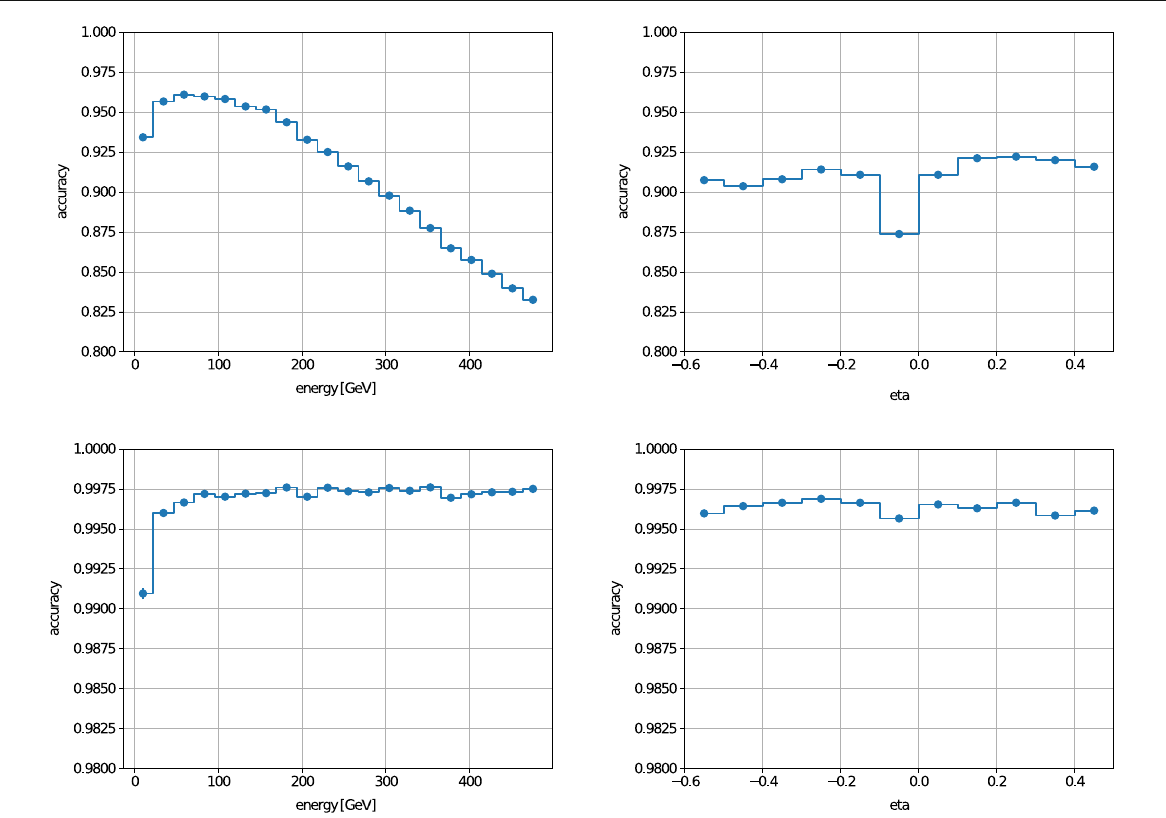
Fig. 14 Classification accuracy of best performing network for γ vs. π 0 (top) and e vs. π ± (bottom), in bins of energy (left) and η